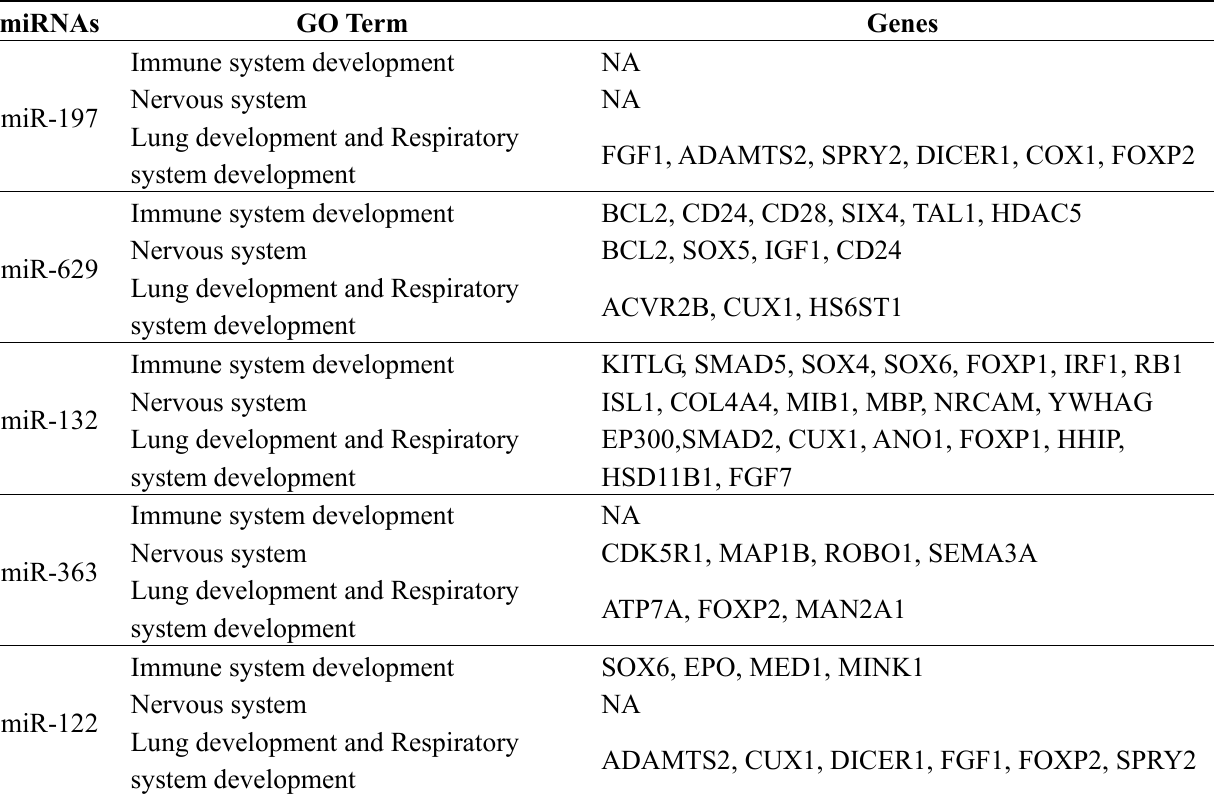
Table 4. The list of genes predicted to be targeted by the candidated